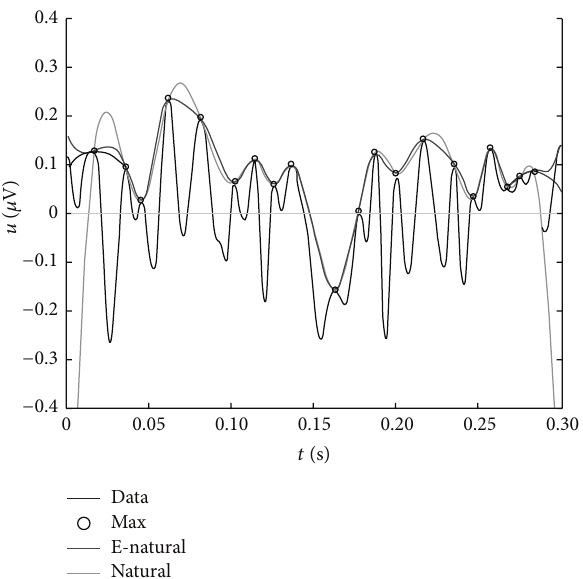
Figure 6: Different methods comparison results about the end effect.